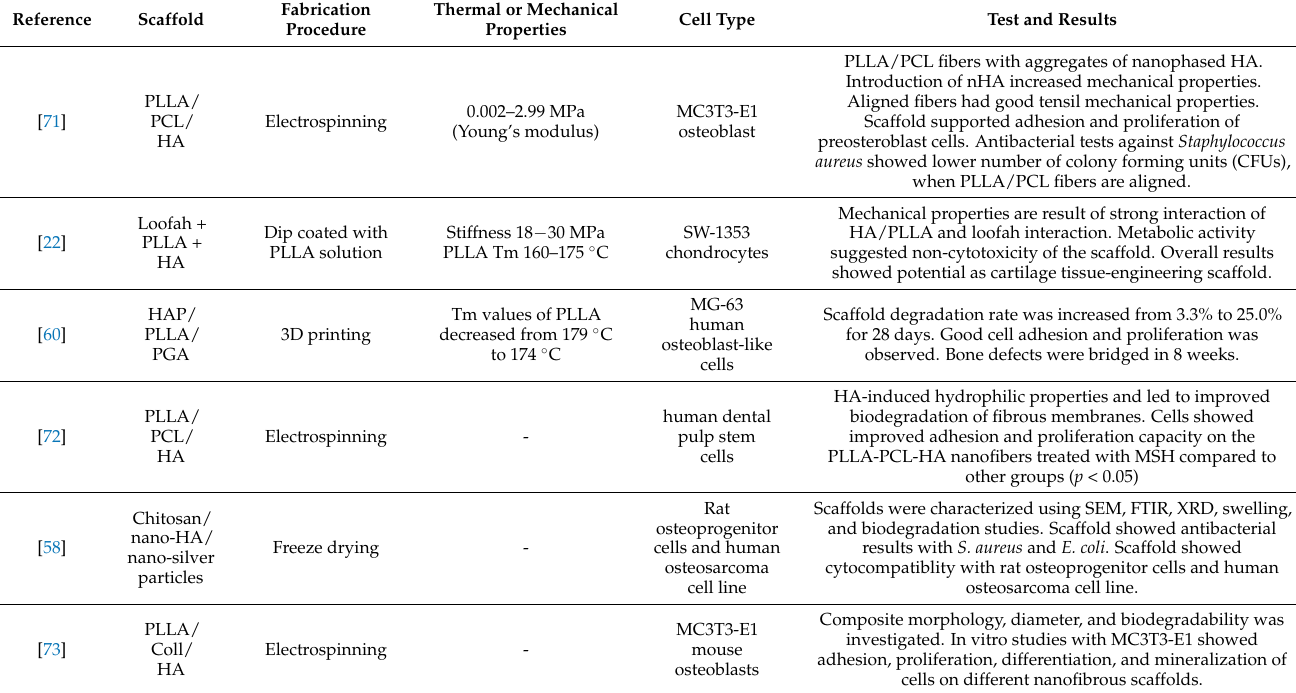
Table 6. Description includes studies for bone-tissue engineering scaffolds to improve PLLA/HA nanocomposites. Reference